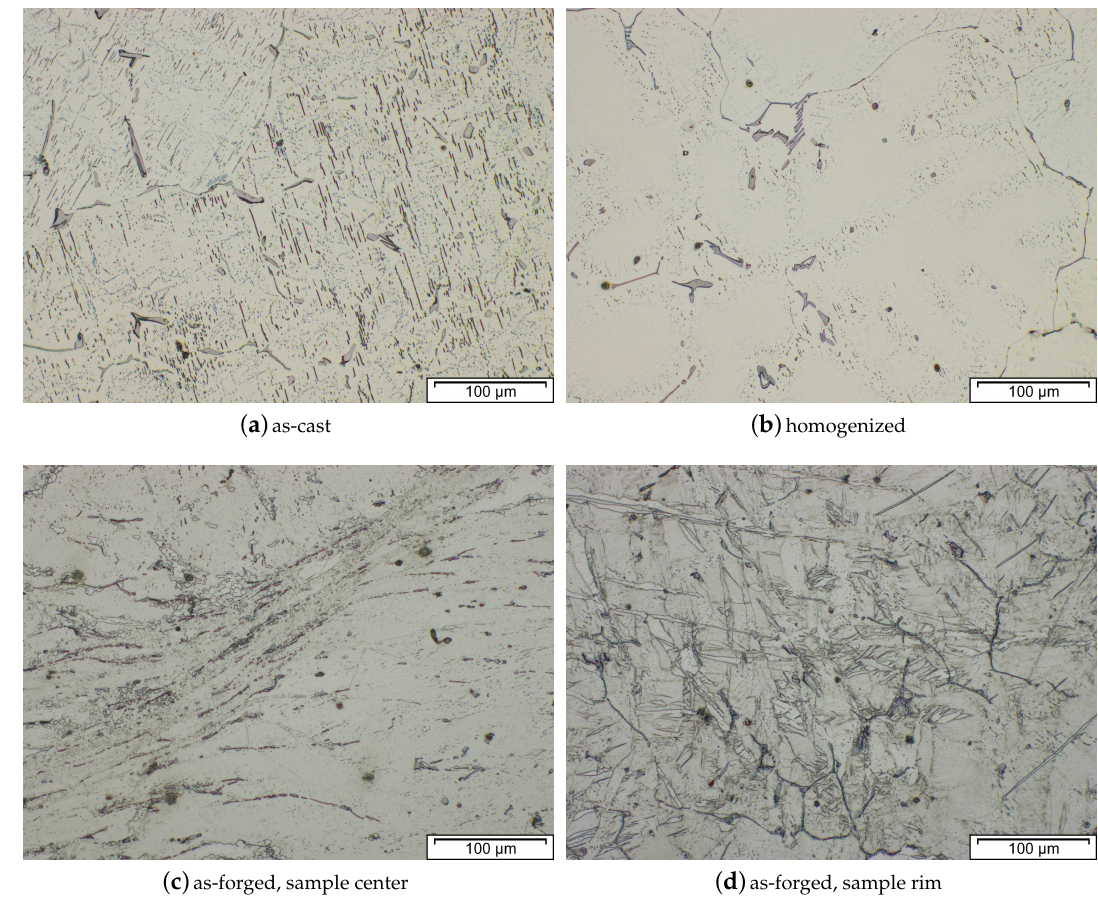
Figure 19. Microstructure of AZXW3110 in consecutive processing steps: ( a )as-cast, ( b )homogenized at 415 ◦ C for 24h. Forging took place using a material temperature of approx. 425 ◦ C, die temperatures of 280 ◦ C and a ram speed of 10mms − 1 . The as-forged microstructures of parts quenched in water are shown in: ( c )center area having high degree of deformation and ( d )flange area with a lower degree of